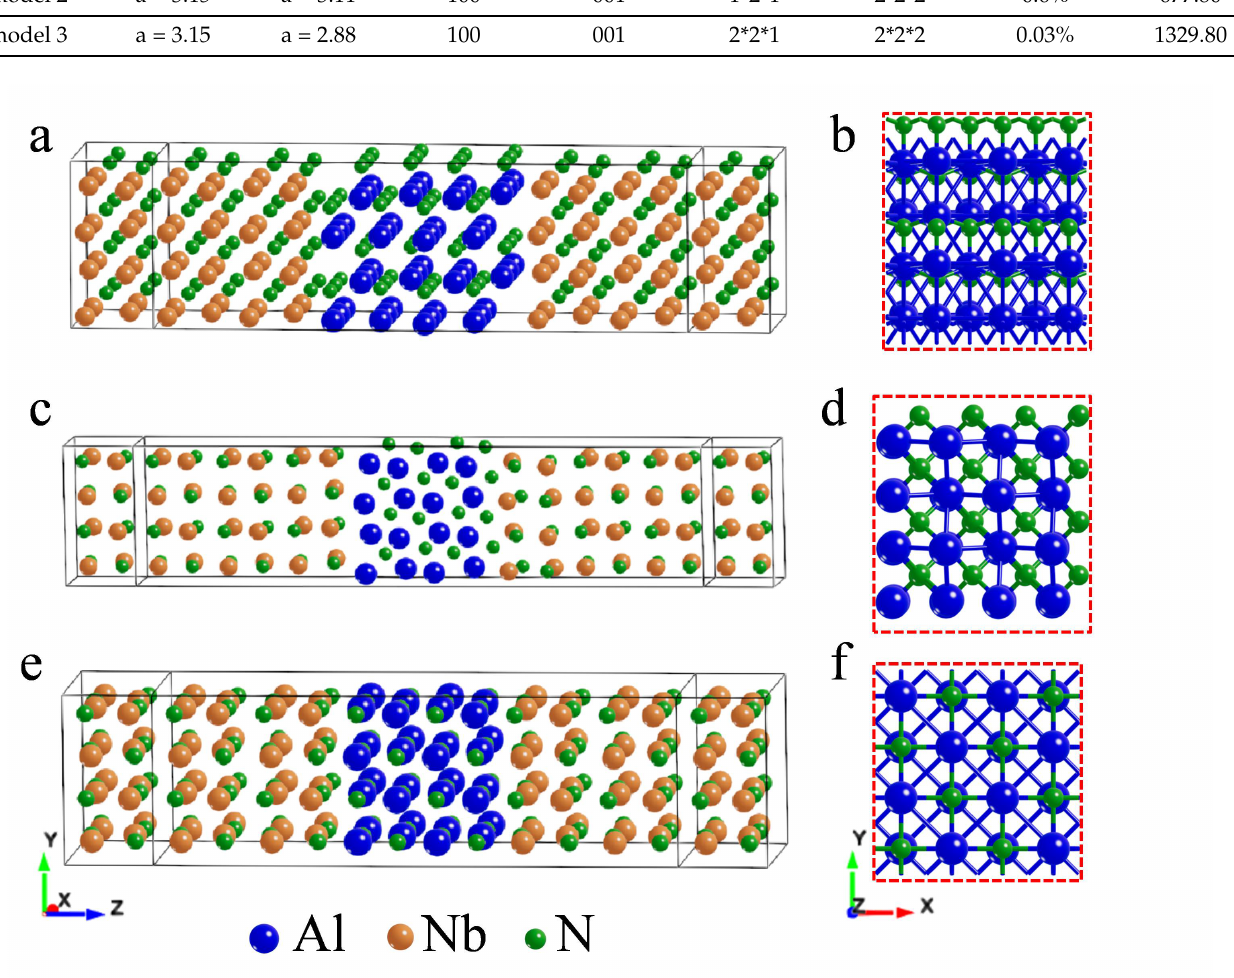
Figure A1. Schematic diagram of different material models. ( a ) three-layer structure model 1 of NbN (100) and hexagonal AlN (100); ( b )the structure of the barrier layer AlN in the x – y plane in the model 1; ( c ) three-layer structure model 2 of NbN (100) and tetragonal AlN (001); ( d ) the structure of the barrier layer AlN in the x – y plane in the model 2; ( e ) three-layer structure model 2 of NbN(100)